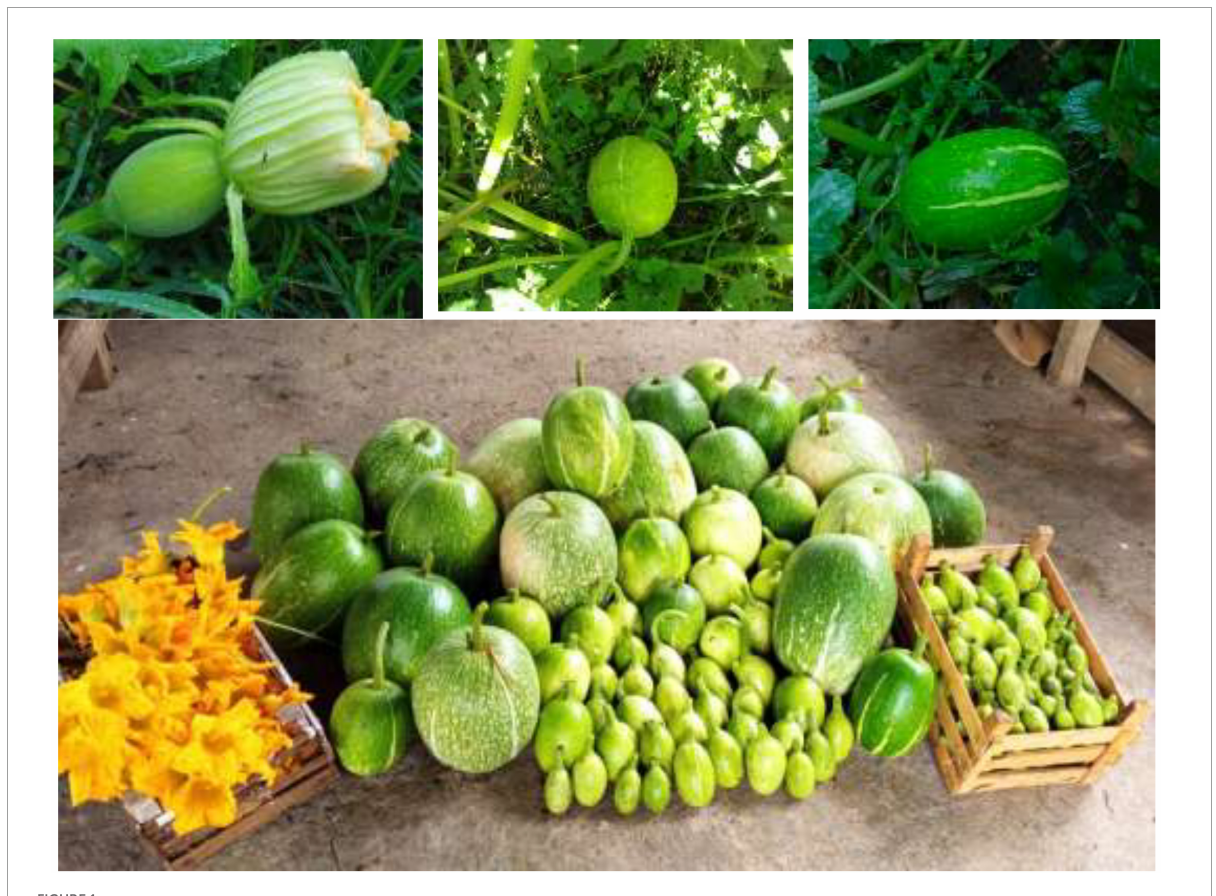
FIGURE1 Fruits of Cucurbita ficifolia at different growth